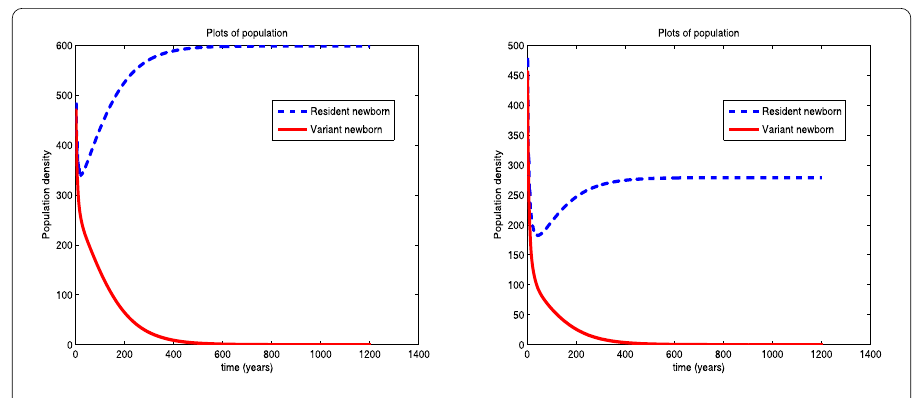
Figure 9 Region IVa. Plot of newborn populations vs time. Parameters: h 2 = 0.5, h 3 = 0.7 on the left h 1 = 0 and on the right h 1 = 0.2.